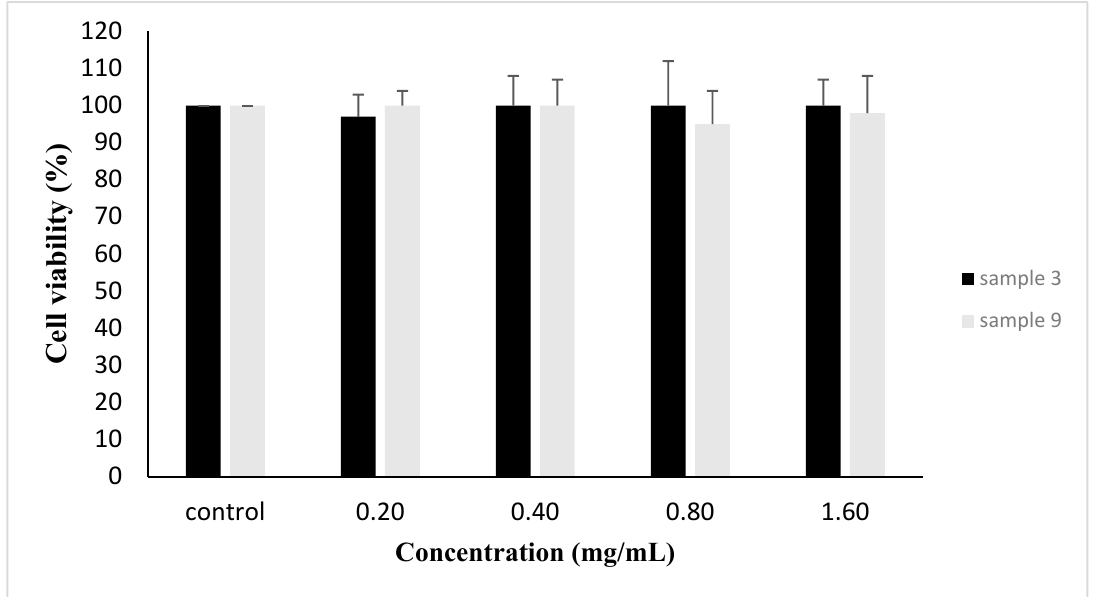
Figure 1. Cell viability following the treatment of EAhy.926 cells with samples 3 and 9. The results are presented as the means ± SEM of three independent experiments carried out in triplicate. * p < 0.05 indicates significant difference from the control value.